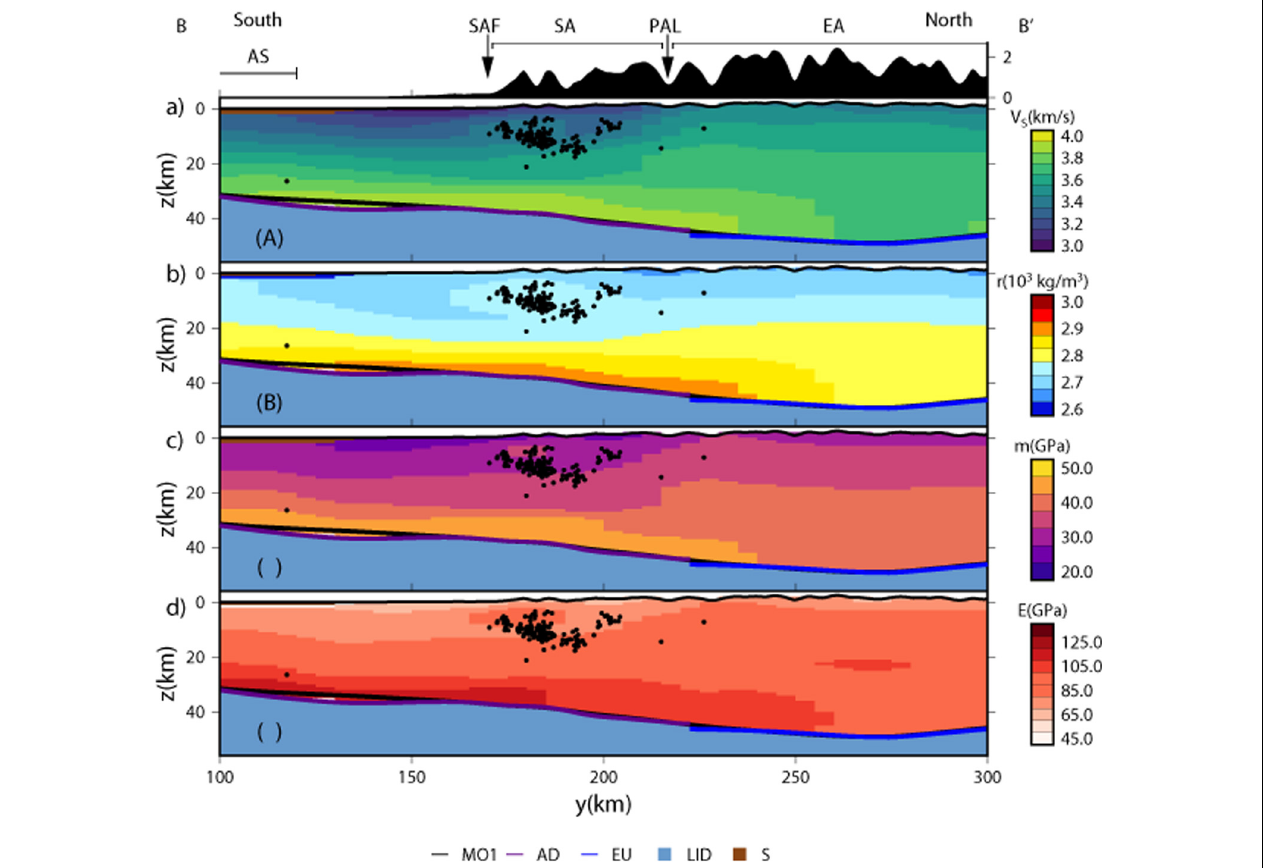
FIGURE 11 | Vertical section for the well-defined part of profile BB’ ( Figure 9E ; starting from y = 100 km) with the values of (A) V S , (B) ρ ; (C) µ , and (D) E. Black line: trace of MO1; violet line: trace of Adria (AD) Moho; blue line: trace of Eurasia (EU) Moho; black dots: hypocenters of earthquake with M D ≥ 2.0 and distance ≤ 10 km from profile BB’ for the 1988–2018 time span extracted from the OGS bulletins 1 . SA, Southern Alps; EA, Eastern Alps; AS, Adriatic Sea; SAF, Southern Alps foothills; PAL, Periadriatic